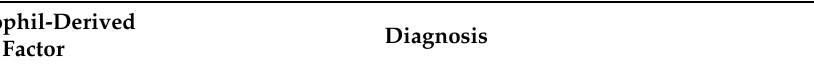
Table 1. Summary of discussed study characteristics on potential neutrophil-derived biomarkers in